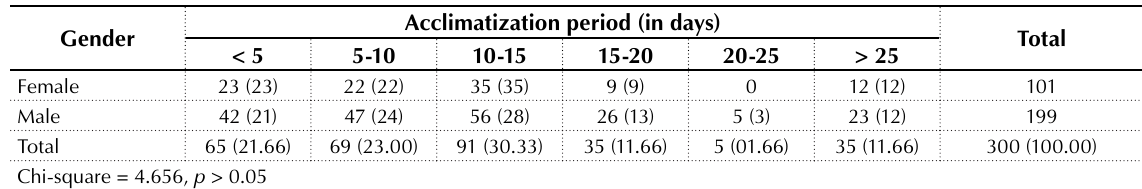
Table 2. Cross tabulation between gender and acclimatization period Gender